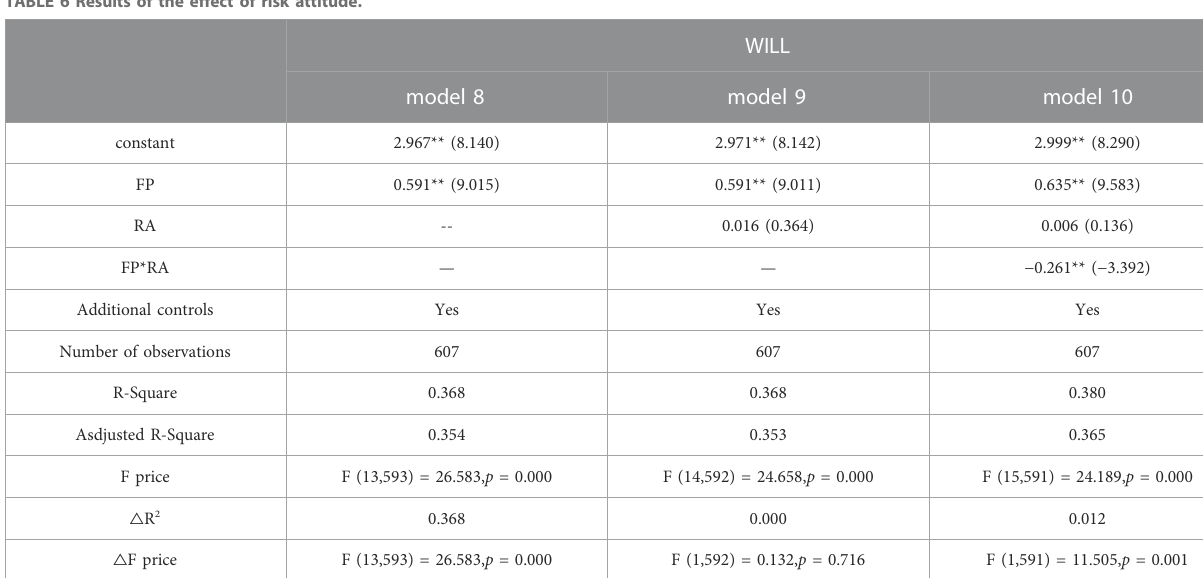
TABLE 6 Results of the effect of risk